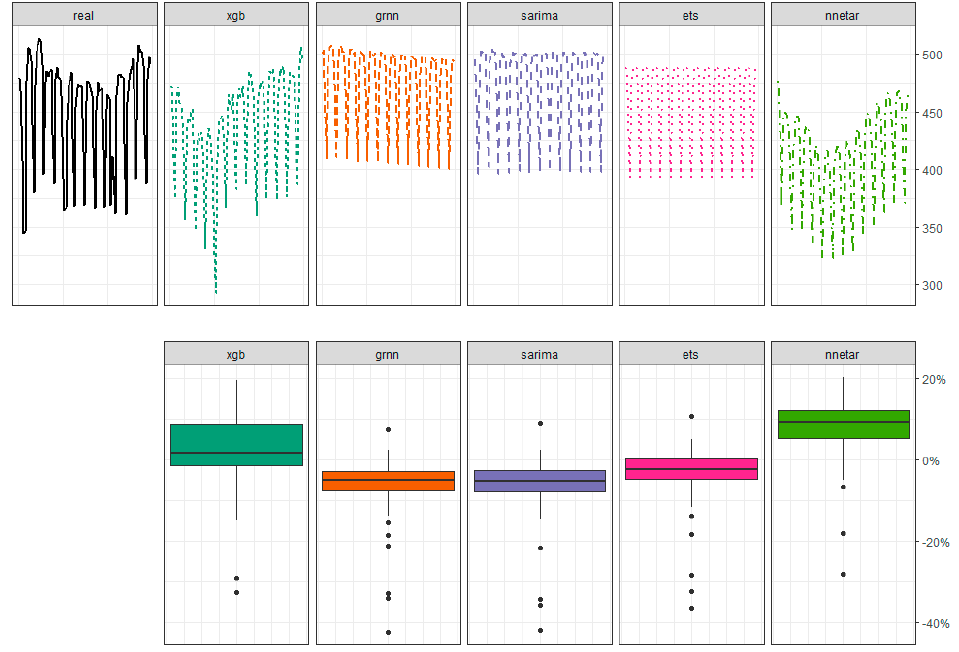
Figure 11. Quarterly forecast; Top panel: actual and forecast consumption course, bottom panel: boxplots of the relative error distribution of the forecasts in the tested scenario.